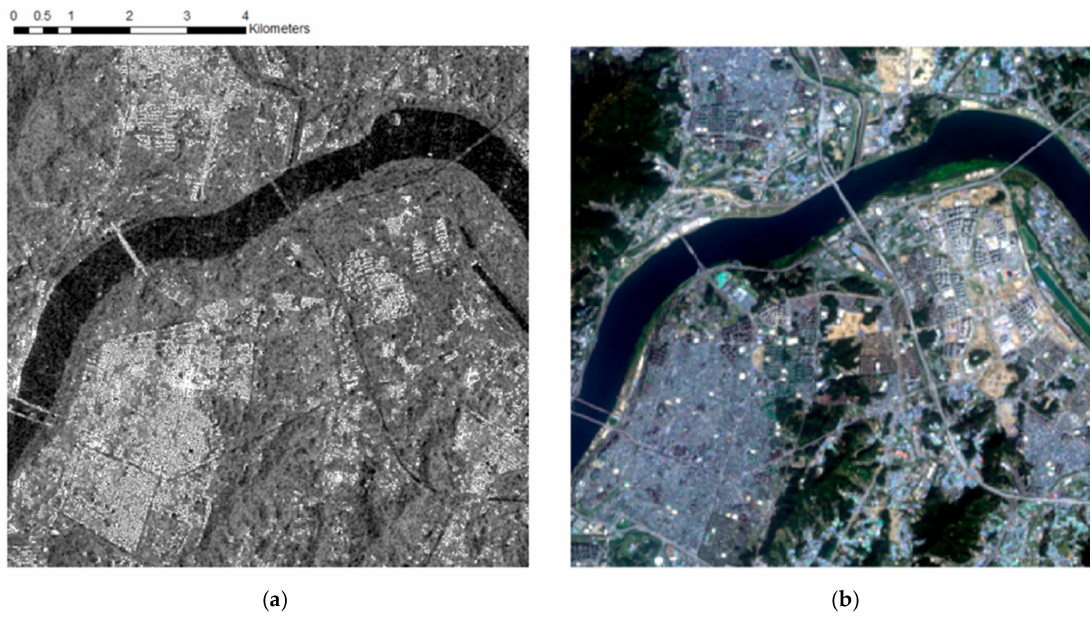
Figure 2. Experimental area of Site 2: ( a ) KOMPSAT-5 image acquired on 21 August 2014. ( b ) reference Landsat-8 OLI image acquired on 24 September